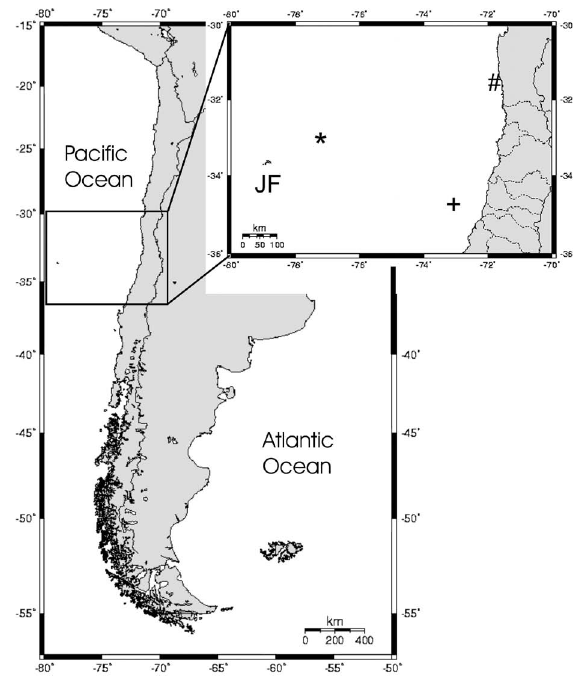
Fig . 1. – Map of the Chilean coast highlighting its central portion and the location of each new species’s type locality. # , Poecillastra antonbruunae n. sp. (off Constitución); *, P. maremontana n. sp. (off Juan Fernandez Archipelago); and +, P. sinetridens n. sp. (off Zapallar, Valparaiso). JF, Juan Fernandez